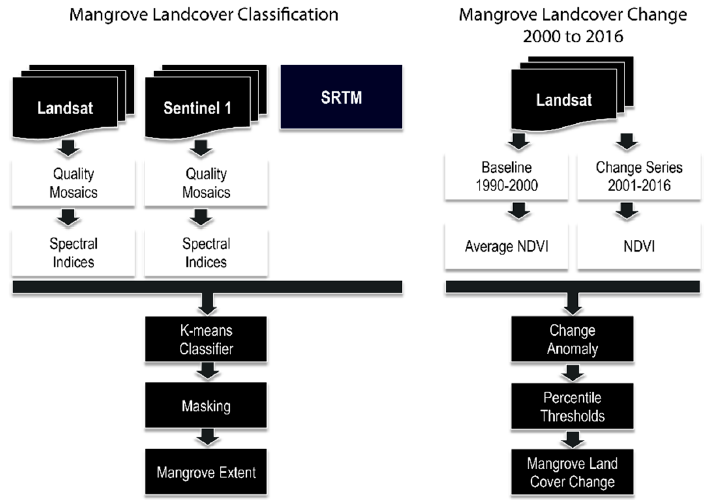
Figure 2. Schematic of the methodology used for mangrove land cover classification and for assessing mangrove land cover change from 2000 to 2016.